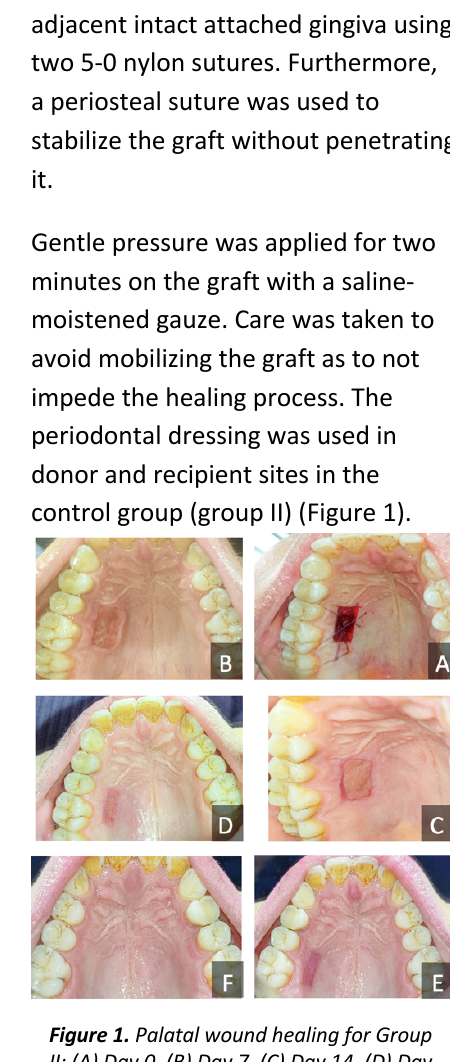
II: (A) Day 0, (B) Day 7, (C) Day 14, (D) Day 21, (E) Day 28, and (F) after two months